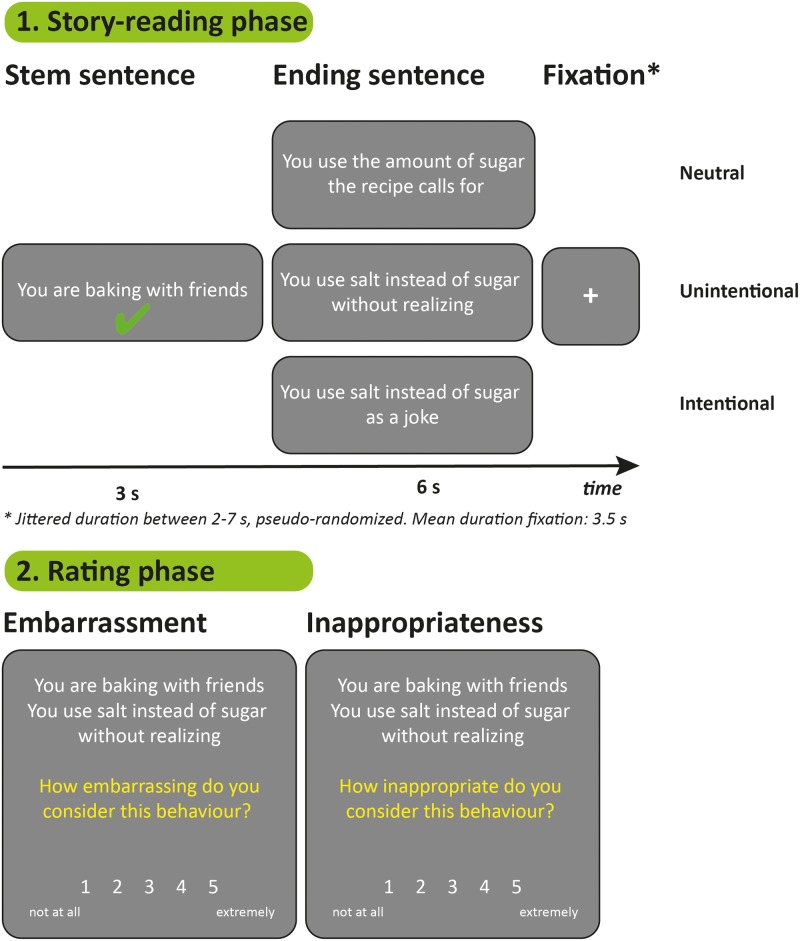
Overview of the revised Social Norm Processing Task (SNPT-R).During the story-reading phase (1), participants read stories consisting of a stem sentence and an ending sentence, describing either a neutral social situation, a situation in which a social norm was unintentionally transgressed or situation in which a social norm was violated intentionally. Participants were instructed to imagine themselves in the situation described. In the rating phase (2), participants rated all stories on embarrassment and inappropriateness.